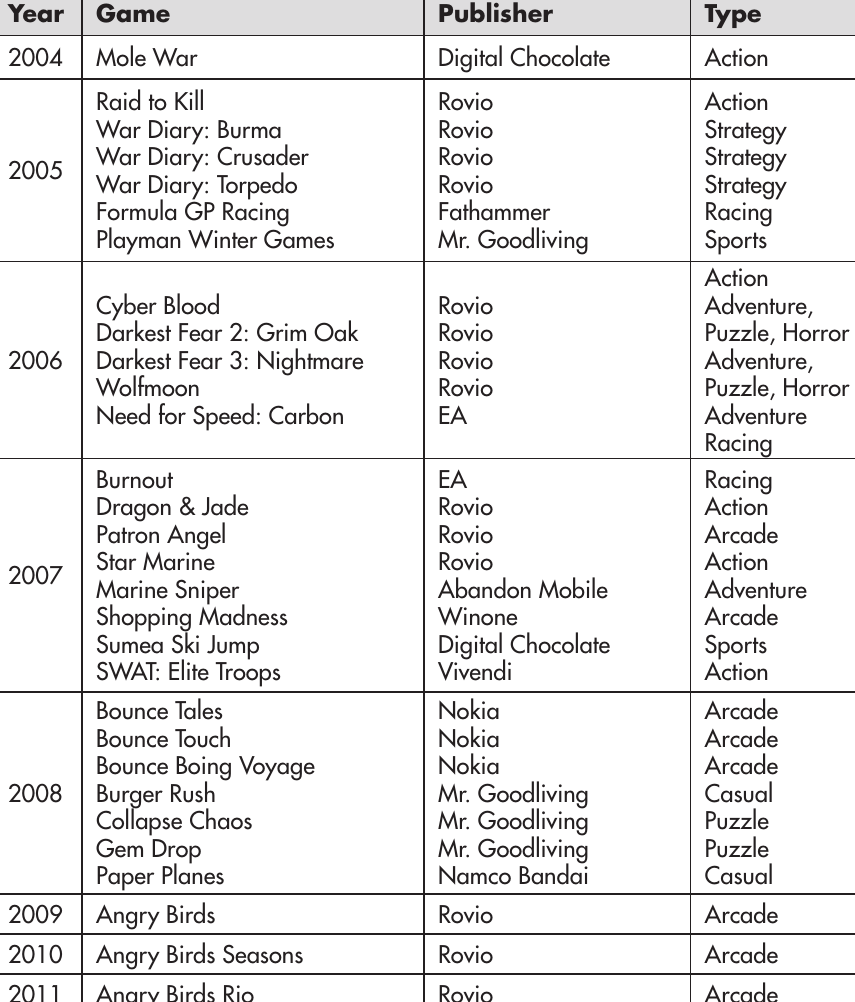
Table 4 Main game products of